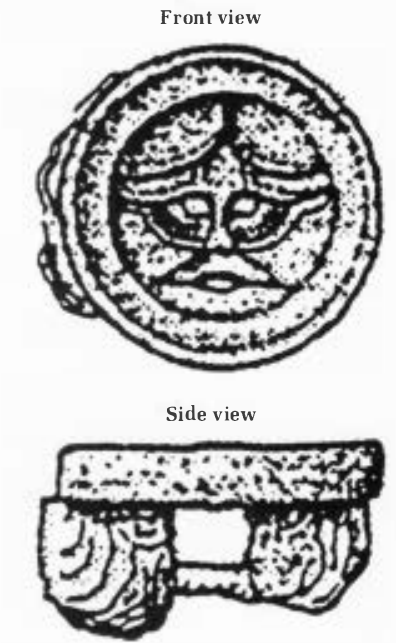
Figure 2 One of a pair of Anglo-Saxon button brooches from the Merovingian­ period cemetery at Criel-sur-Mer (Seine­ Maritime). The brooch is similar in size to a modern coat button and consists of cast copper alloy with gilding on its front sur­